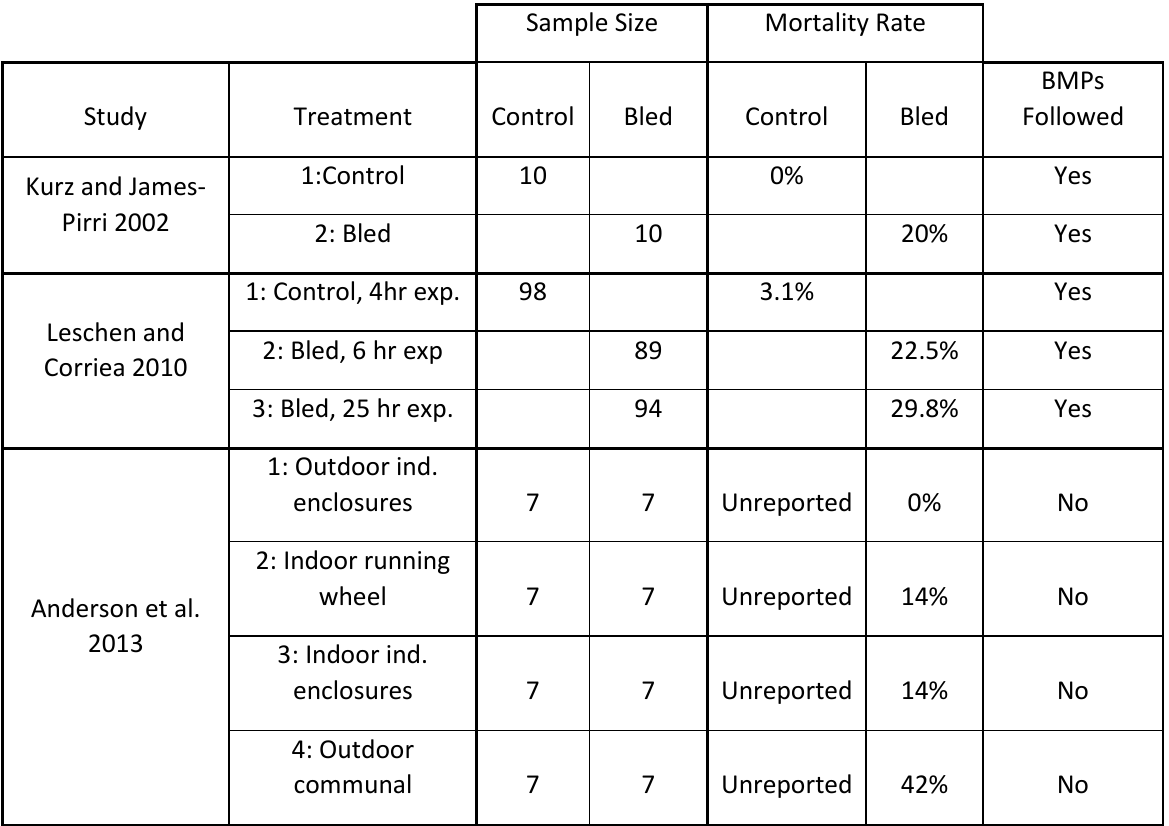
Table 1. Summary of three biomedical horseshoe crab bleeding mortality papers from the northeast region. All three studies focused only on female crabs. Control = non-bled